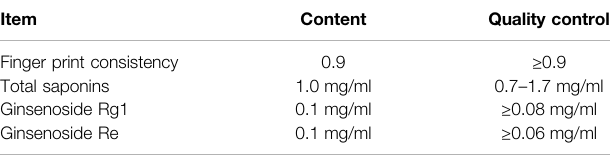
TABLE 2 | Quality analysis of Shenfu injection (Batch Number: